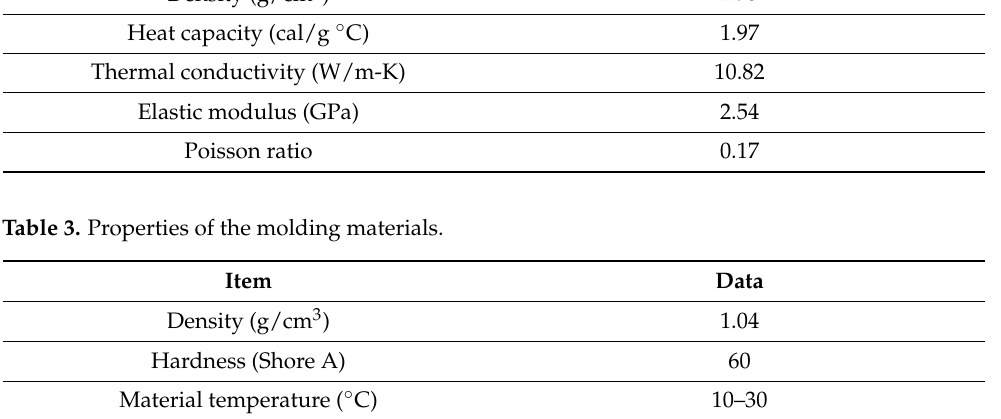
Table 1. Process conditions used in the simulation.